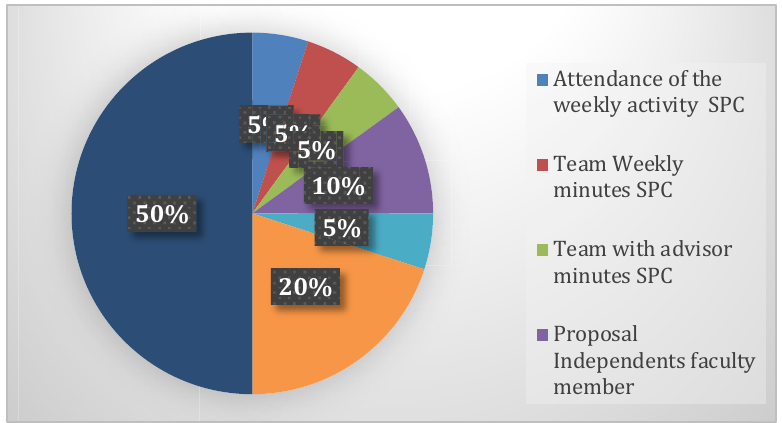
Fig. 10. Scores distribution of the senior project course (SPC)